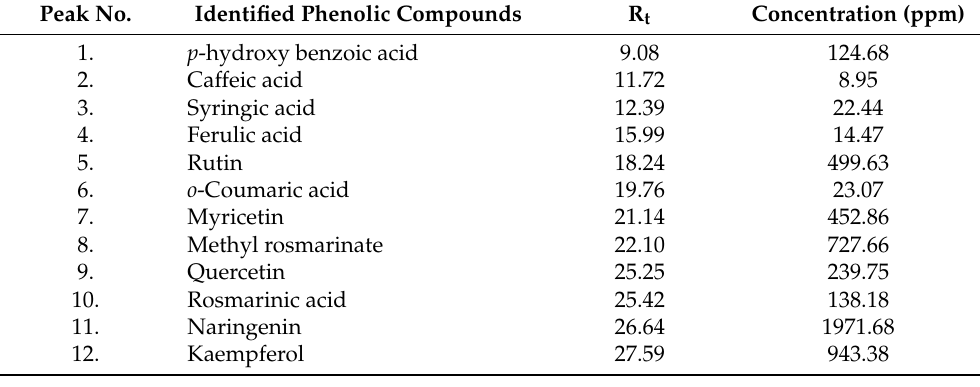
Table 1. Identified phenolic compounds in Cordia africana Lam. stem bark ethanolic extract by HPLC at λ max 284 nm.